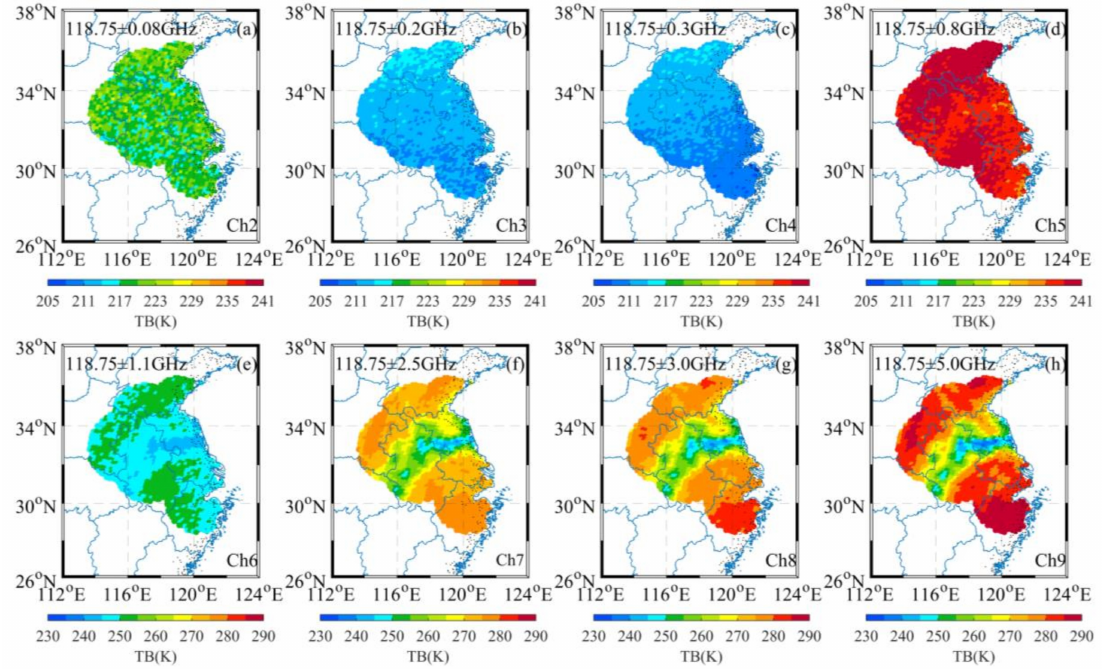
Figure 3. Spatial distribution of satellite-observed brightness temperature for temperature-sounding channels on 4 July